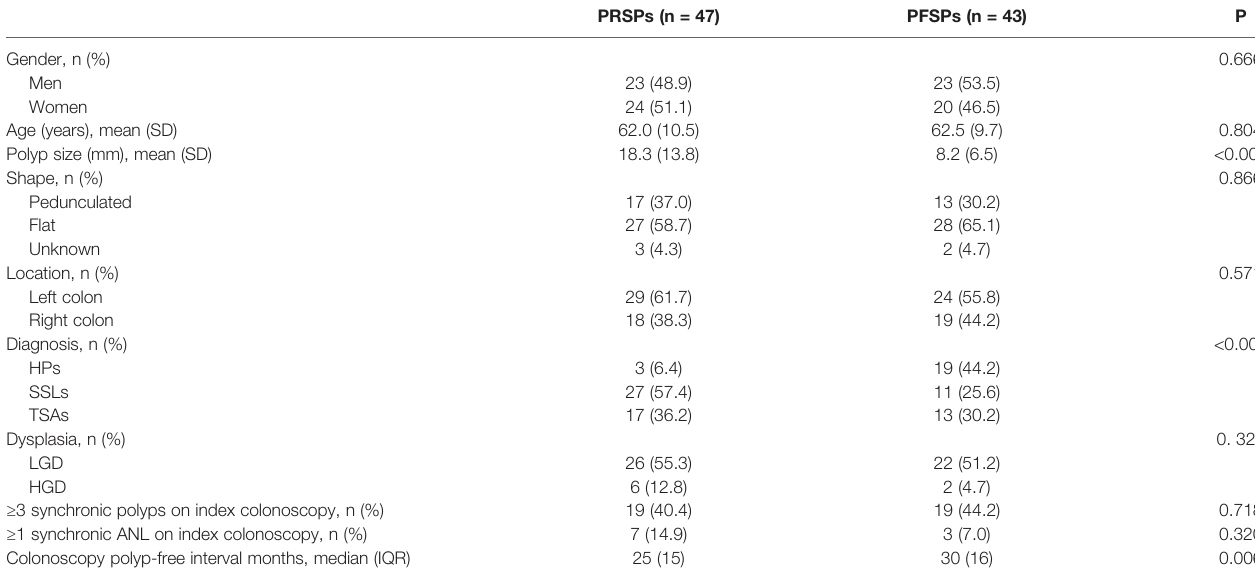
TABLE 1 | Baseline characteristics of PRSPs and PFSPs after variant fi ltration (n = 90).